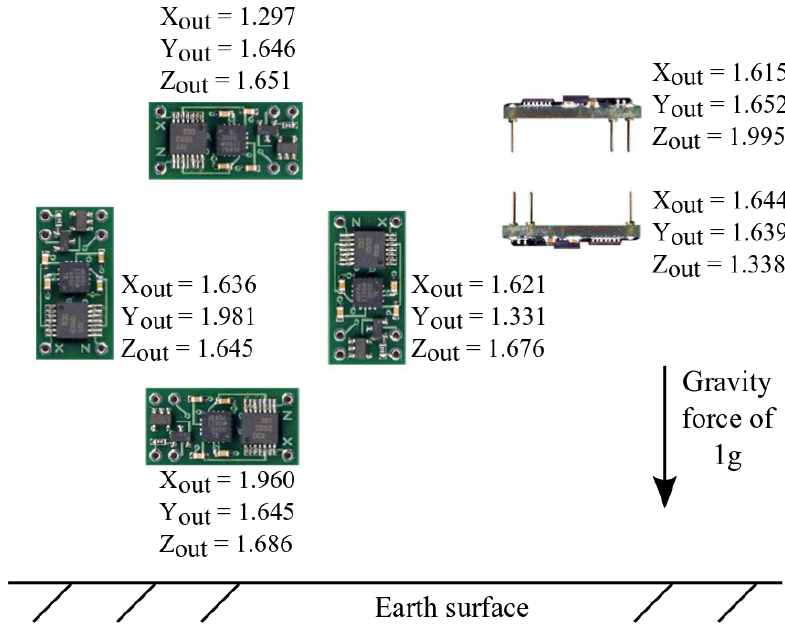
Figure 4. Calibration of the accelerometer in the x , y and z directions. The measurements are expressed in volts. The figure is based on